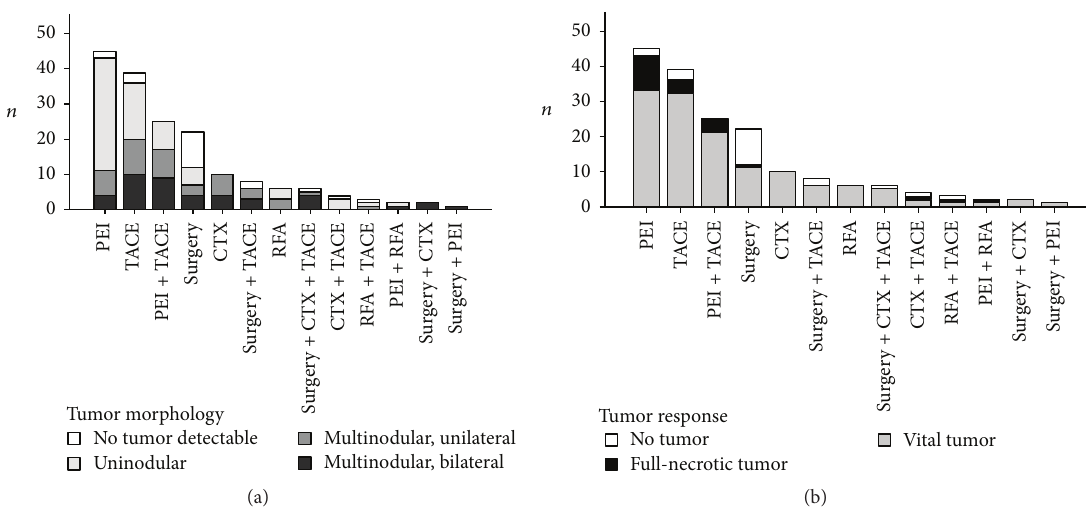
Figure 4: HCC morphology per treatment group (a) and tumor response to pretreatments (b) as measured in numbers of nondetectable, full- necrotic, or vital tumors. Percutaneous ethanol instillation (PEI) ( 𝑛 = 45 ), transarterial chemoembolisation (TACE) ( 𝑛 = 39 ), and surgery ( 𝑛 = 22 ) were most frequently applied. Another major treatment group were patients that had been treated by a combination of PEI and TACE ( 𝑛 = 25 ). There were a significant higher number of uninodular tumors in the PEI group (71%) as compared to the TACE group (41%). The TACE group also had a significant higher proportion of multinodular tumors (52%) as compared to the PEI group (25%) and a higher proportion of multinodular/bilateral tumors, which was three times as high as compared to the PEI groups (26% to 9%, resp.). The pretreatment group surgery had the highest rate (45%) (10 of 22) of explanted livers without detectable tumor remnants, but this difference was statistically not significant as compared to the proportion of full-necrotic and nondetectable tumors ( 𝑛 = 10+2 ) in the PEI group (Fisher’s exact test 𝑝 = 0.099 ). The PEI group and TACE group were comparable in terms of remaining vital tumor tissue (Fisher’s exact test 𝑝 = 0.439 ).